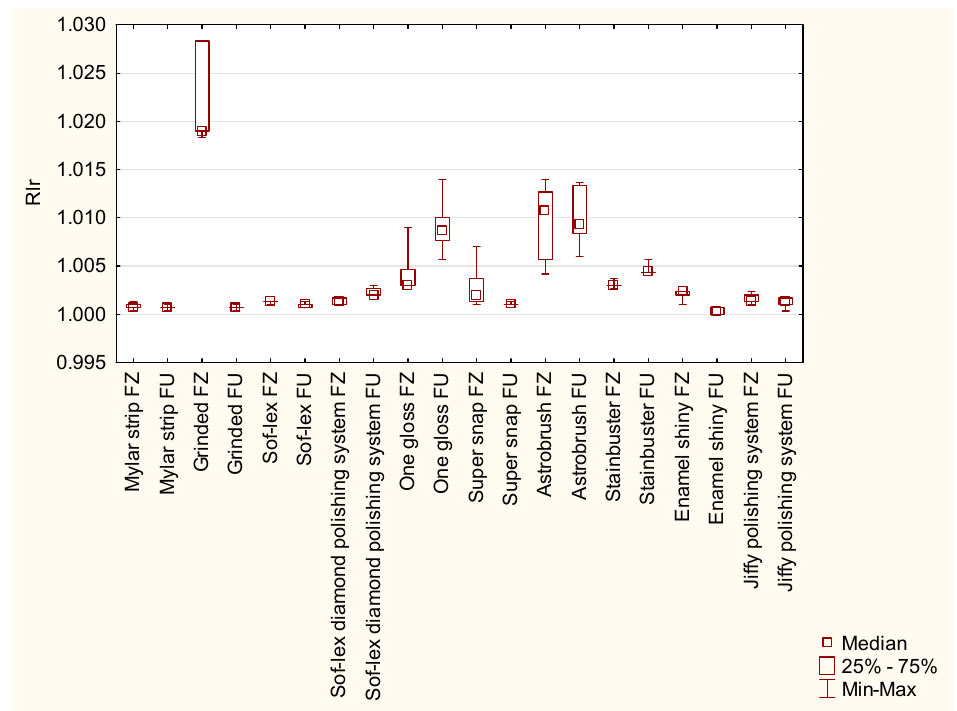
Figure 2. Median analysis, Rlr comparison between FU and FZ.